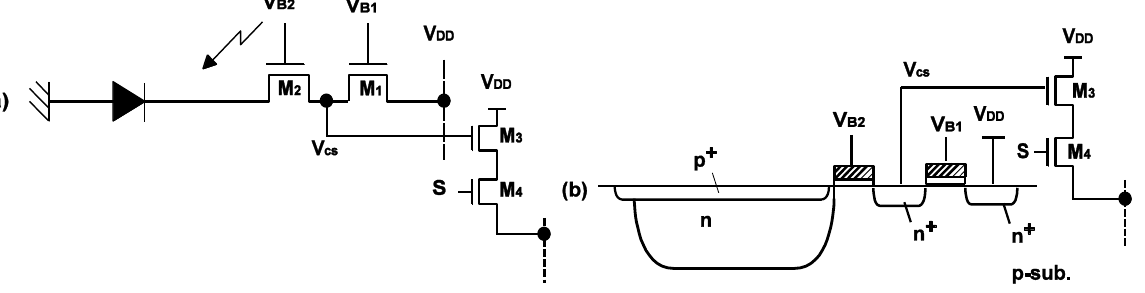
Figure 10. (a) LPR cell (b) Cross section of LPR